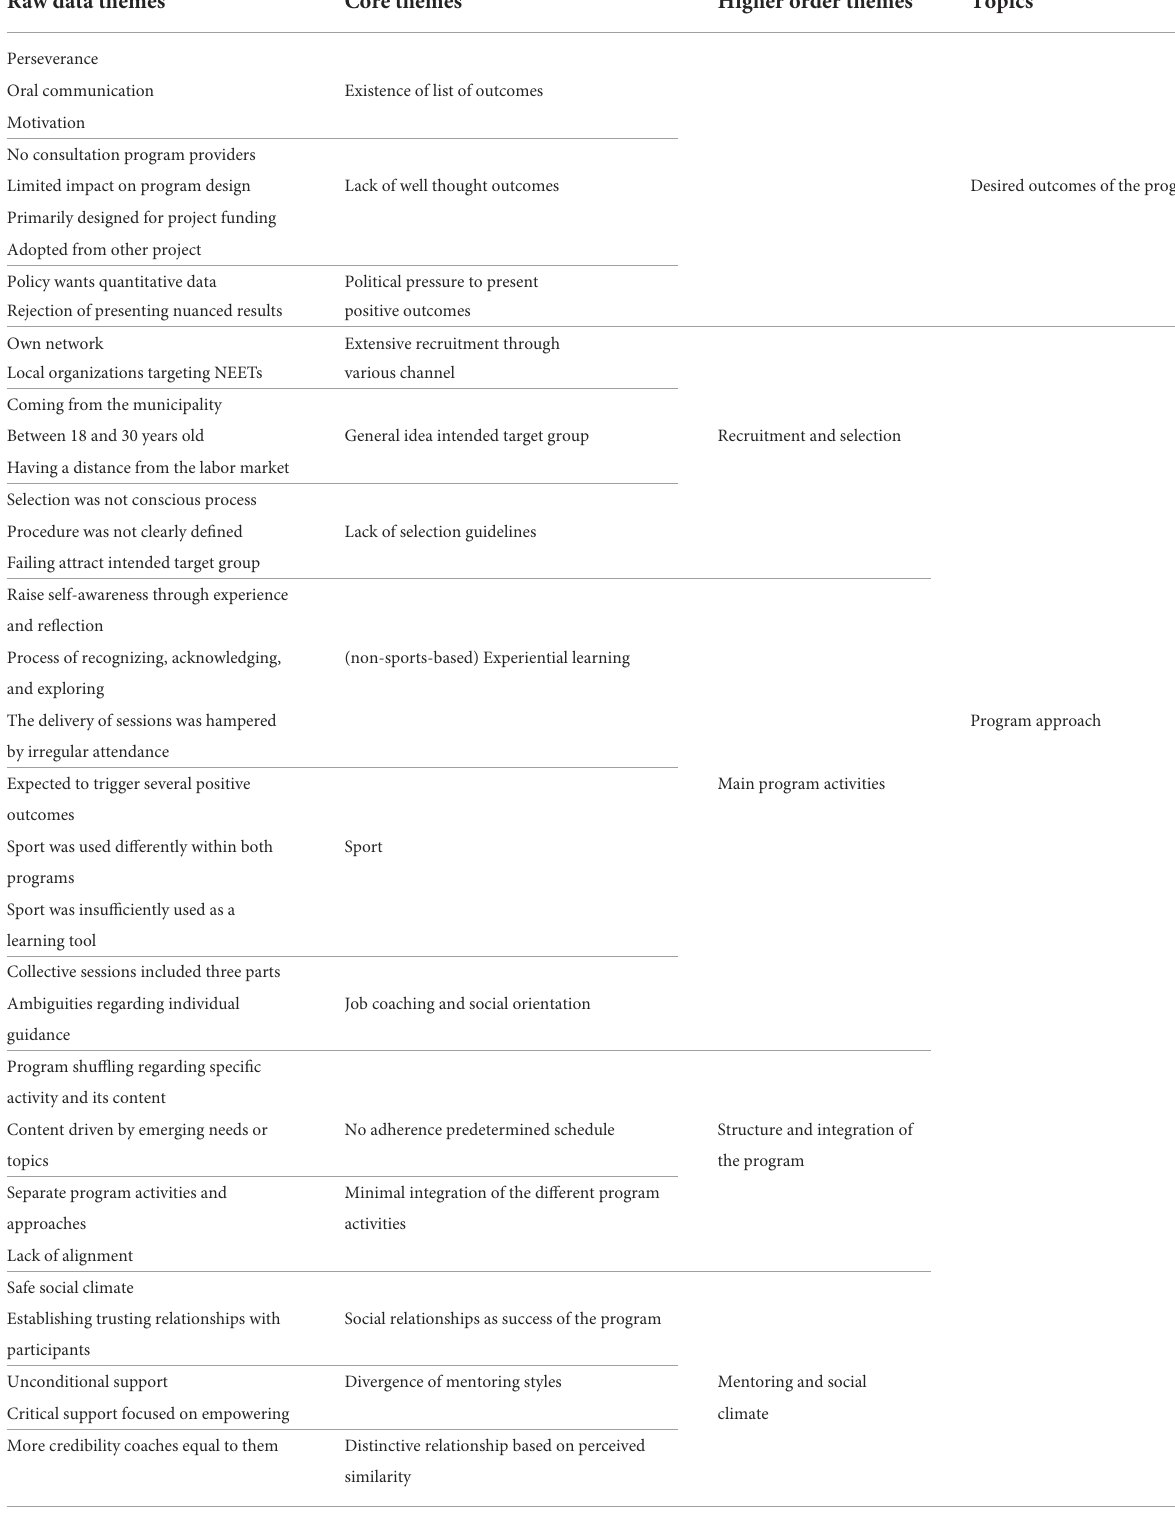
TABLE 2 Overview of the SfE program construction and